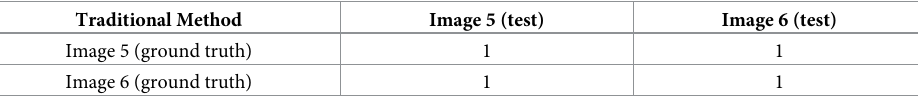
Table 2. Precision values output from the traditional pixel-level evaluation method of the simulated grayscale images of adjacent cells (Fig 3).